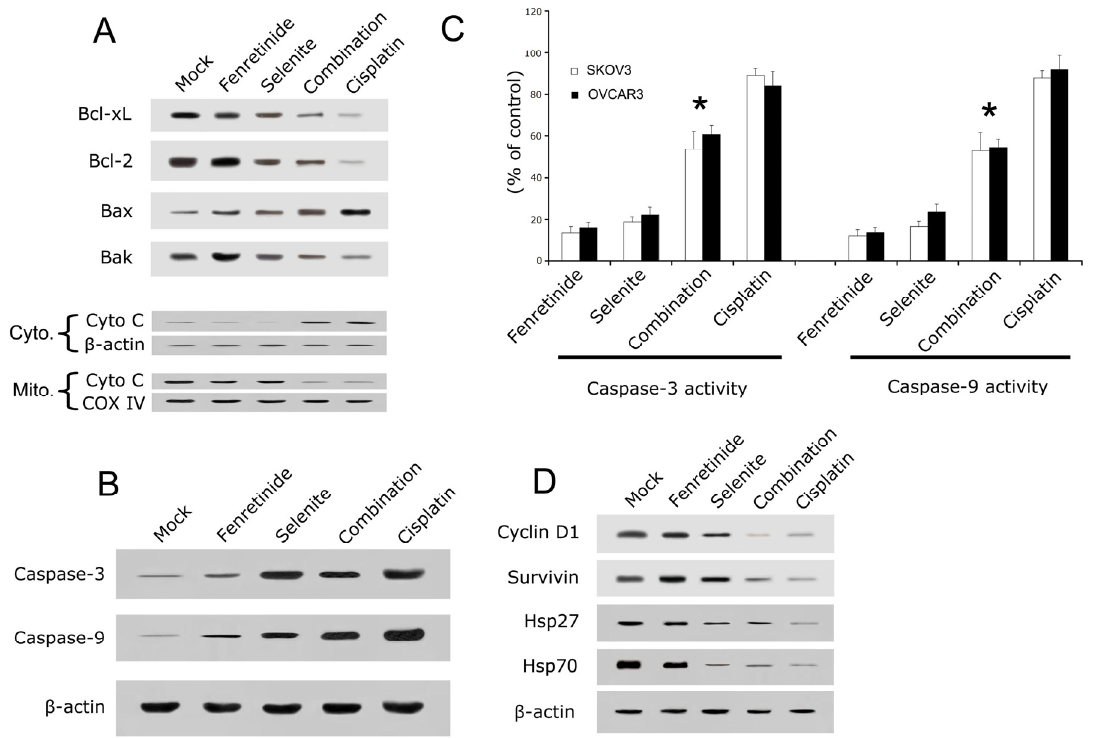
Figure 3. Apoptosis related protein expression by Western blotting and the caspase 3/9 activity analysis. After drug alone (10 µmol/L fenretinide, 10 µmol/L selenite) or drug combination (10 µmol/L fenretinide plus 10 µmol/L selenite) exposure for 48 h, Western blotting was performed with antibodies against apoptosis related protein such as Bcl-xL, Bcl-2, Bax, Bak and cytochrome c ( A ); Cleaved caspase-3 and caspase-9 ( B ); Caspase-3 and Caspase-9 activity was also measured ( C ); Cell cycle related protein Cyclin D1 and Survivin, the heat shock proteins Hsp27 and Hsp70 expression were analyzed ( D ). (means ± s.d., * p <